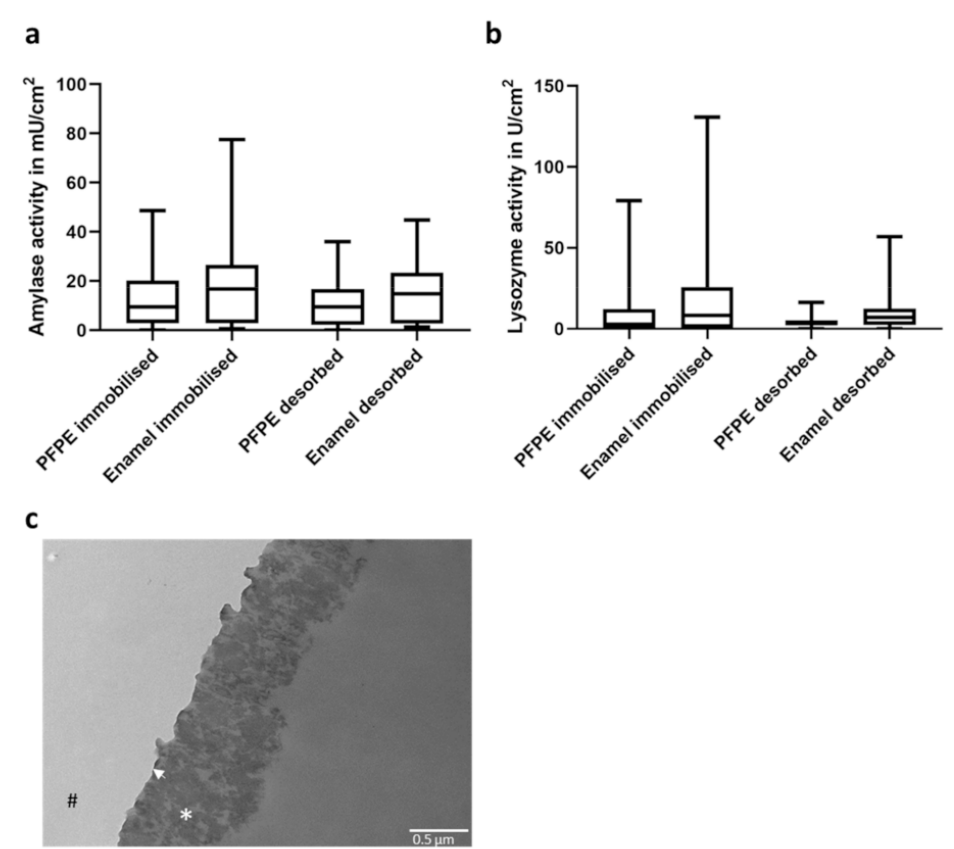
Figure 1. Activity of enzymes in the oral acquired pellicle. The activity of amylase ( a ) or lysozyme ( b ) was measured within the pellicle formed after 30 min in situ on PFPE or enamel. ( c ) Representative TEM-image of the oral acquired pellicle on PFPE after in situ exposure within the oral cavity for 8 h. An electron-dense basal pellicle layer (arrow) and the more complex thicker globular layer (*) can be distinguished. # PFPE side; magnification